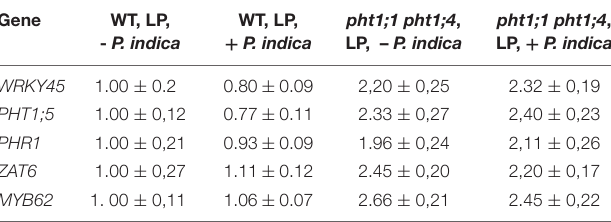
TABLE 3 | Pi starvation response-genes are up-regulated in LP-grown pht1;1 pht1;4 mutant seedlings, in the presence and absence of P. indica . Gene WT, LP, WT, LP, pht1;1 pht1;4 , pht1;1 pht1;4 , + P. indica - P. indica LP, – P. indica LP, + P.